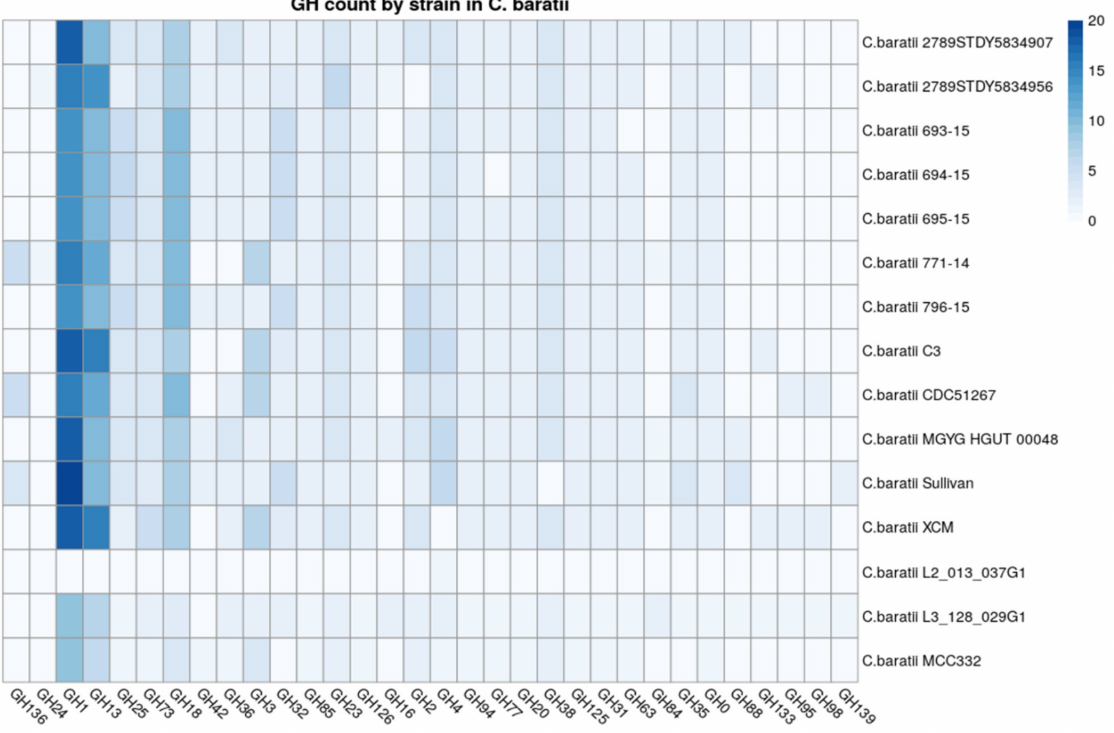
Figure 4. Count of Glycosyl Transferases (GH) categories identified in strains. GHs in Clostridium baratii genomes. The x-axis represents the count of the Glycosyl Transferases category, and the y-axis represents the